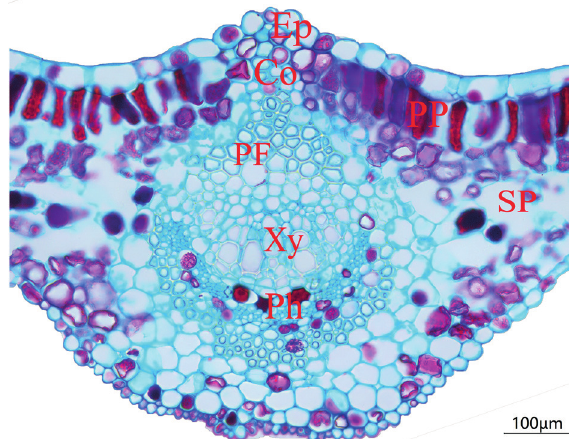
Figure 5 - Transverse section of leaf vein. Ep: epidermides; Co: collenchyma; PP: palisade parenchyma; PF: pericycle fibre; SP: spongy parenchyma; Xy: xylem; Ph: phloem. Bars: 100